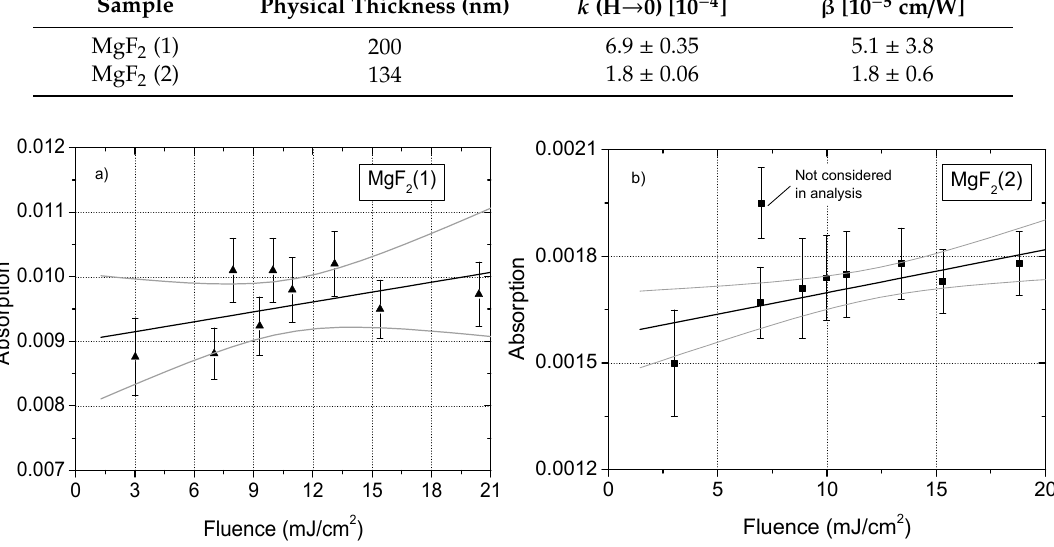
Figure 10. Absorption at 193 nm vs. laser fluence for two different MgF 2 thin films (see Table 1) (Adapted from [25]. Copyright 2009 The Optical Society).